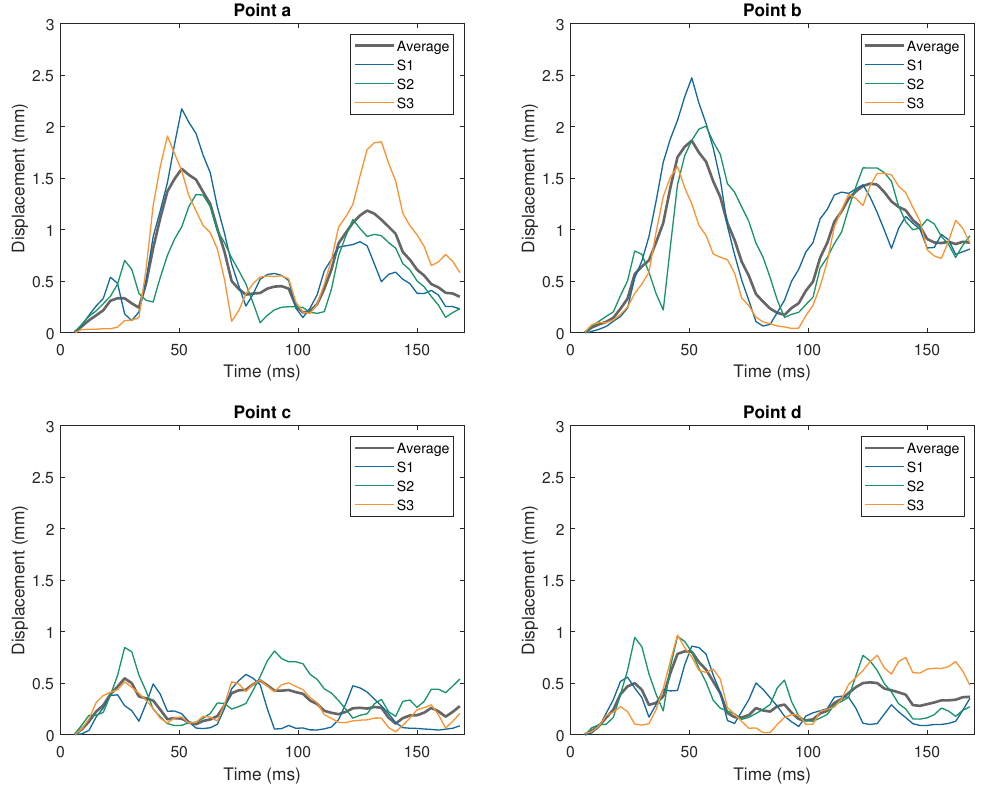
Figure 9. Relative brain displacement magnitude responses to mild frontal impacts conducted by Feng et al. [54] at four discrete points. The chosen locations relate to where NDTs were inserted in specimens during cadaver experimentation [35,36]. Displacements recorded for each of the three subjects (S1, S2, S3) are presented at each location in the original publication and replicated here [54]. As with previous examples, the authors have calculated and present the mean response across all three